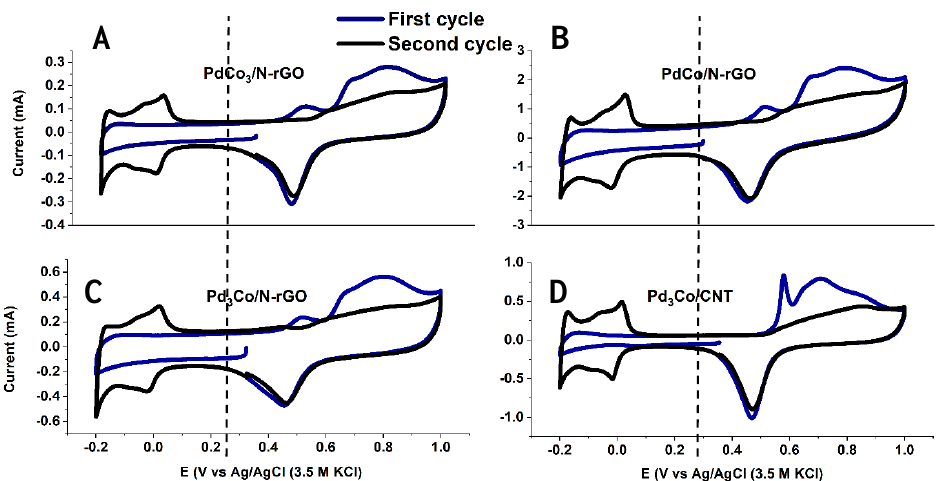
Figure 5. CO stripping voltammetry curves for ( A ) PdCo 3 /N-rGO, ( B ) Pd 1 Co 1 /N-rGO, ( C ) Pd 3 Co/N-rGO, and ( D ) Pd 1 Co 1 /CNT in 0.5 M H 2 SO 4 solution at a scan rate of 20 mv s –1 .